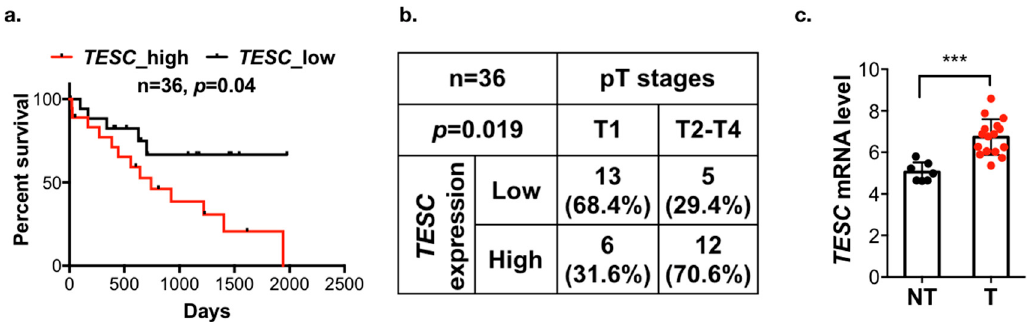
Figure 2. TESC is associated with poor outcomes in patients with cholangiocarcinoma. ( a ) Kaplan–Meier analysis of TESC expression with overall survival in 36 cholangiocarcinoma patients from the TCGA database. ( b ) Chi-square analysis of the association between TESC expression and pT stages in cholangiocarcinoma from the TCGA database. ( c ) Scatter plots of TESC expression in tumor (T) versus adjacent non-tumor tissues (NT) from the GSE32879 database, which contains 16 intrahepatic cholangiocarcinoma (ICC) samples and 7 NT samples. *** p < 0.001.